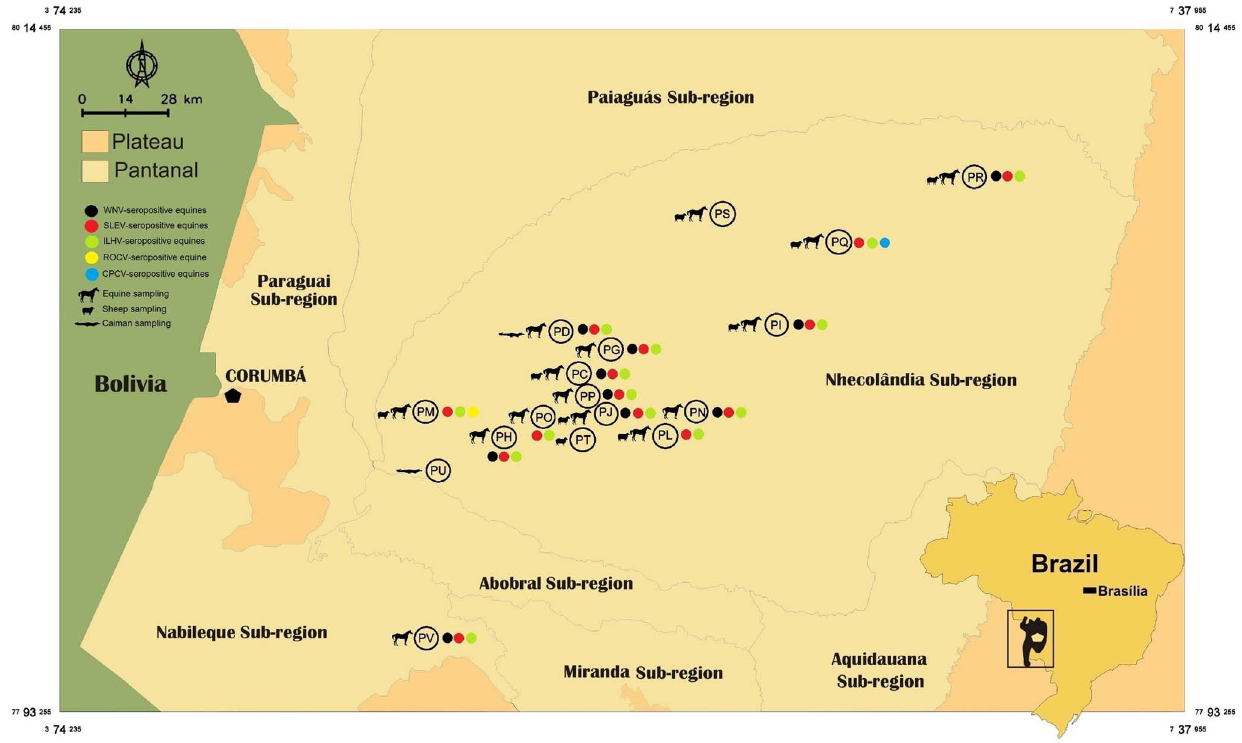
Figure 2. Pantanal ranches where equines, sheep and caimans were surveyed for flaviviruses in the Pantanal. Colored dots mark ranches where seropositive equines with four-fold greater PRNT 90 titer were detected.